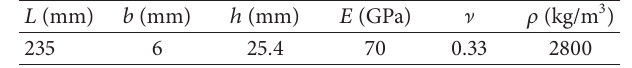
Figure 4: The fundamental frequency ratio of a cracked cantilever beam. Table 3: The material and physical parameters in [19].